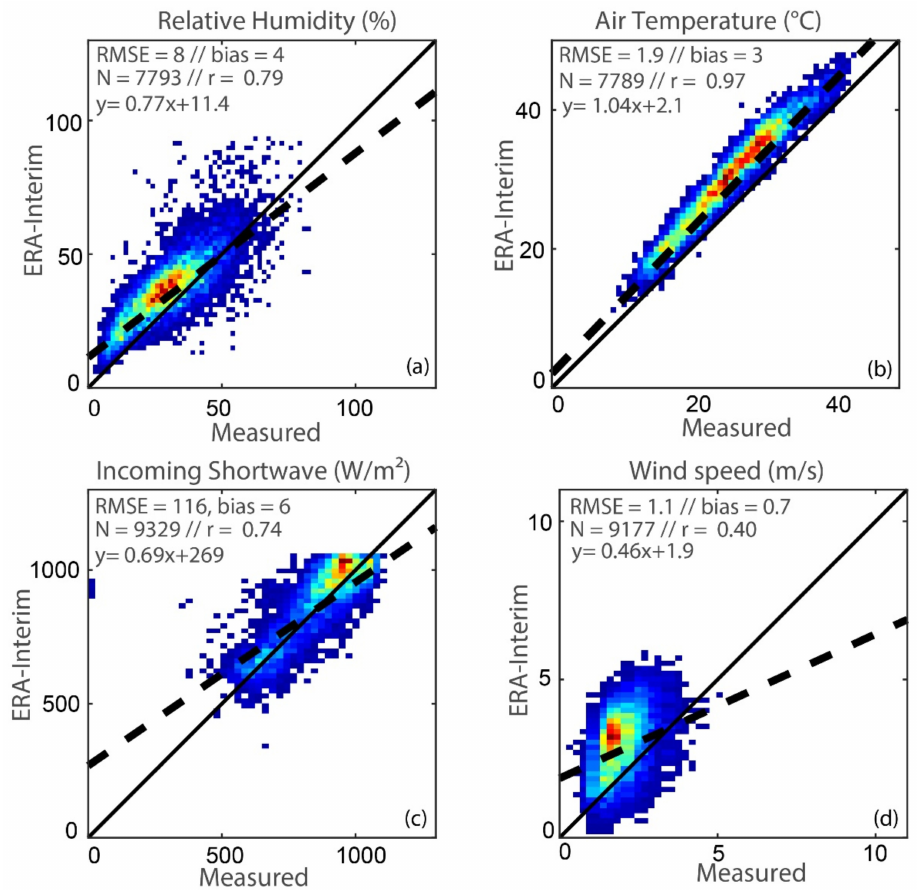
Figure 3. Comparison of the ERA-Interim meteorological variables with measured station datasets ( a – d